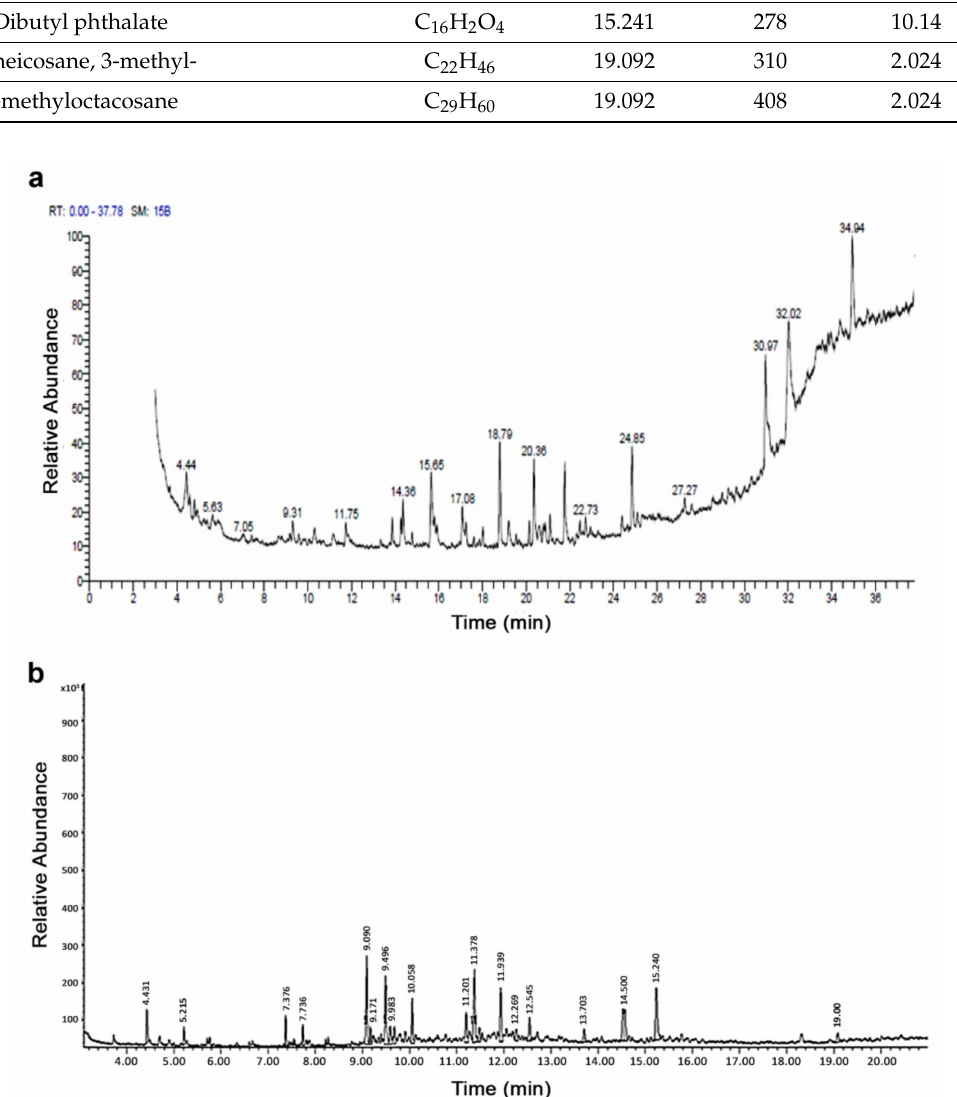
Figure 1. Gas chromatography-mass spectrometry (GC-MS) analysis charts of released volatile organic compounds emitted from S. arghel ethyl acetate ( a ) and methanol ( b ) extracts. The GC–MS analysis of MeoH extract predominantly revealed the presence of the main constituents as Hentriacontane; Sulfurous acid-hexyl octyl ester (11.34%